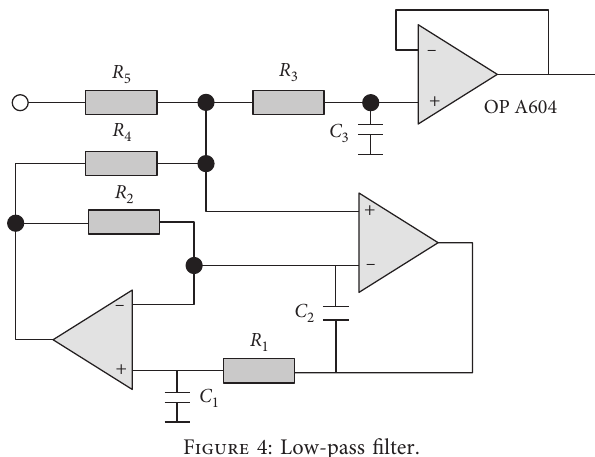
Figure 4: Low-pass filter.